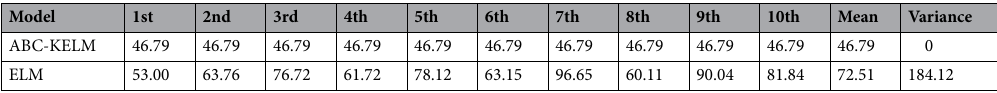
Table 4. The comparison of the REMS values between the ABC-KELM and ELM in 10